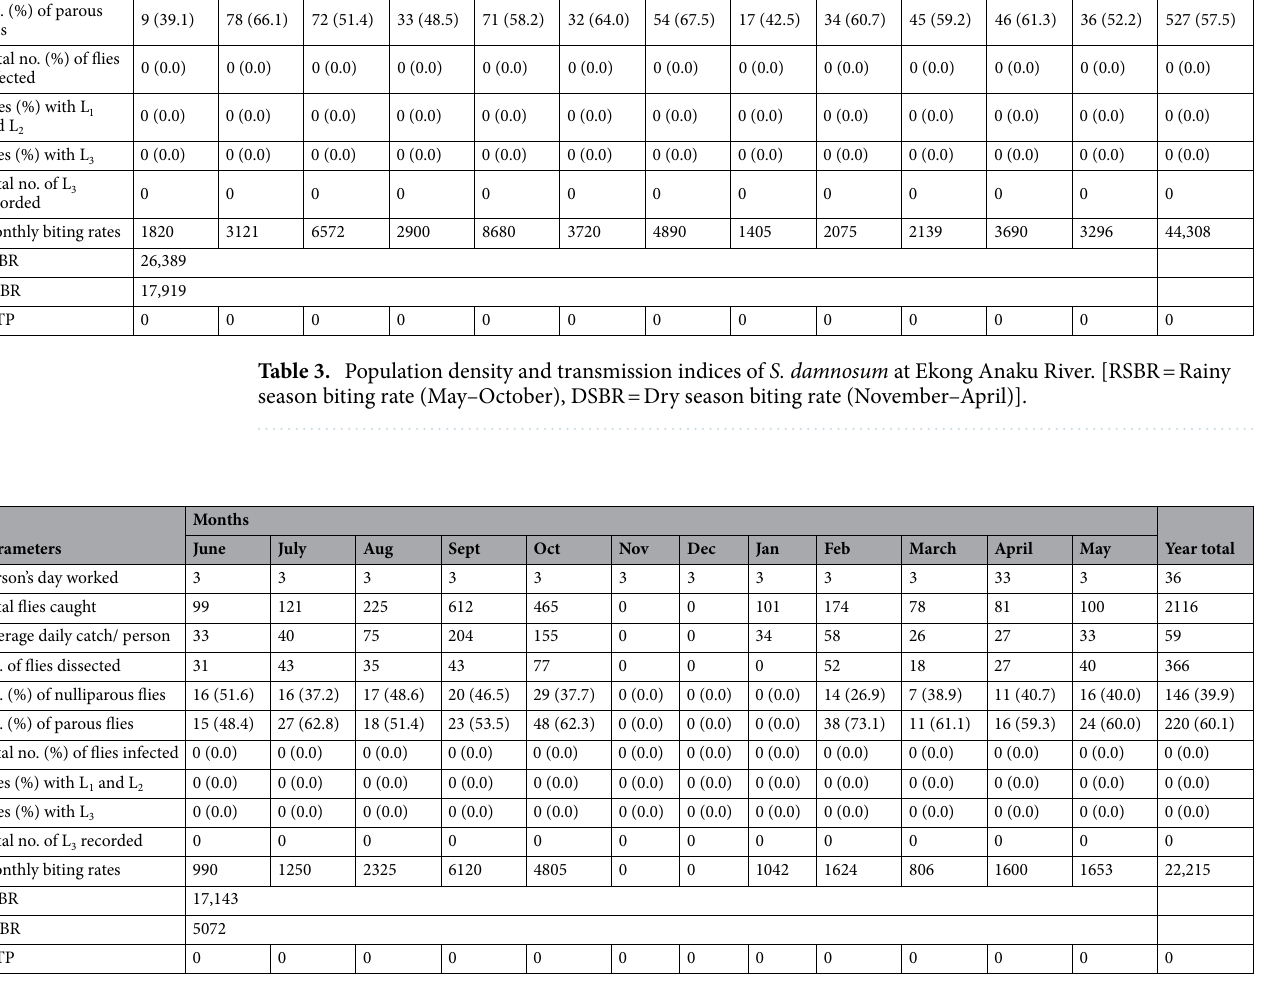
Table 4. Population density and transmission indices of S. damnosum at Afi river (Orimekpang). [RSBR = Rainy season biting rate (May–October), DSBR = Dry season biting rate